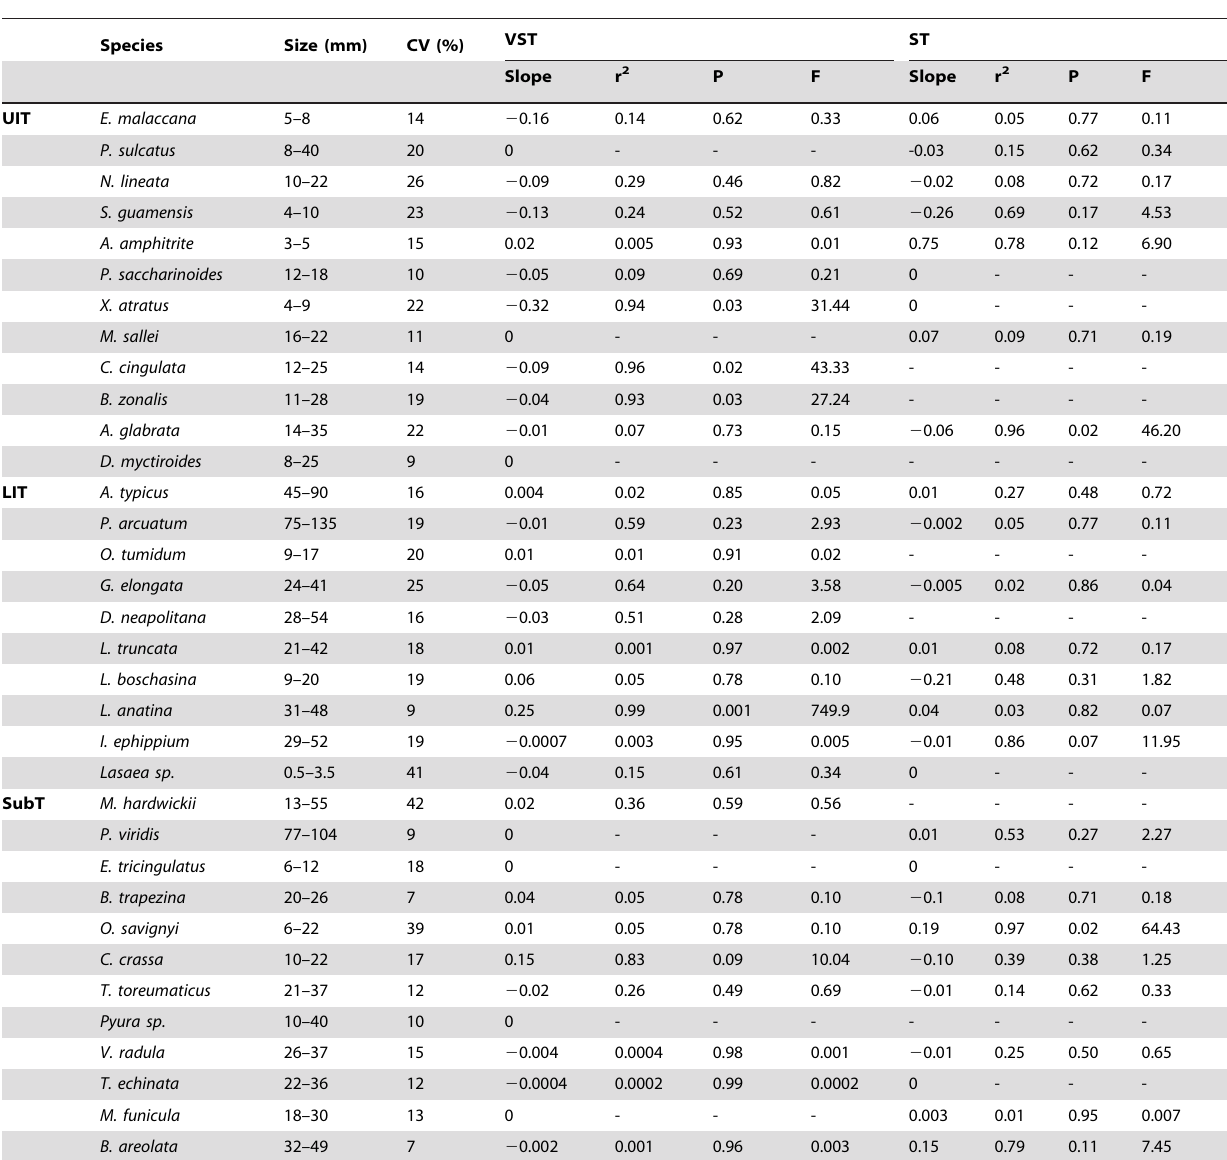
Table 3. Regression parameters for equations relating VST and ST mean UTLs for quartiles calculated on size ranges (mm) of studied